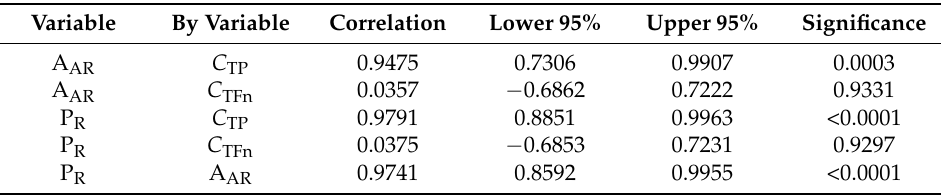
Table 2. Statistical parameters estimated following pairwise